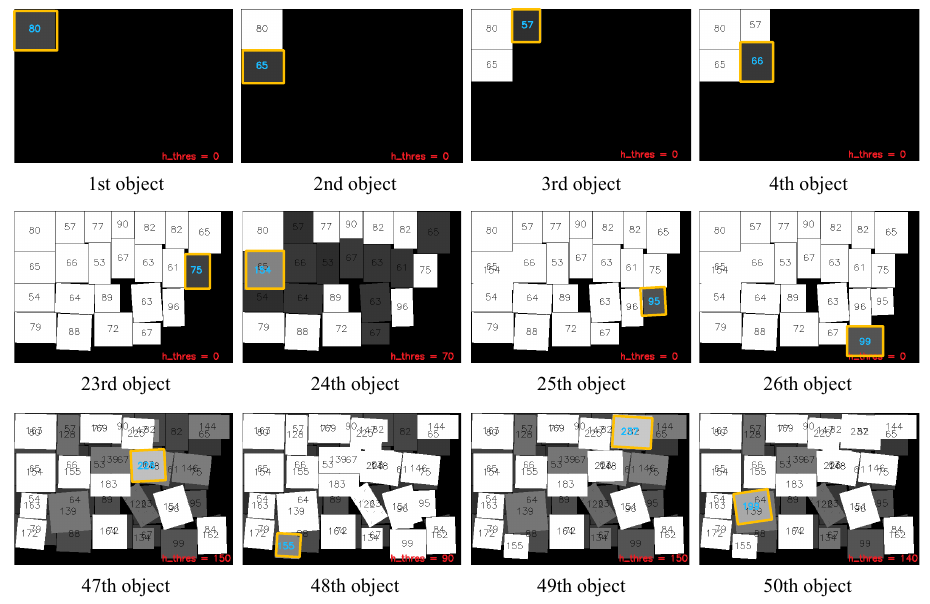
Figure 5. The snap shots of the object-packing simulation without manipulation error (object boundary margin of 1 mm).